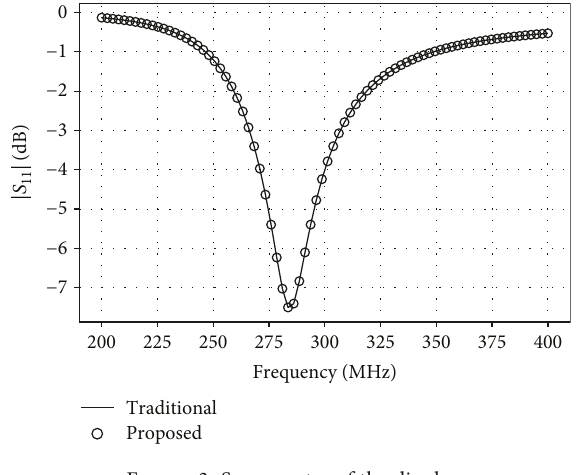
Figure 3: S -parameter of the dipole.